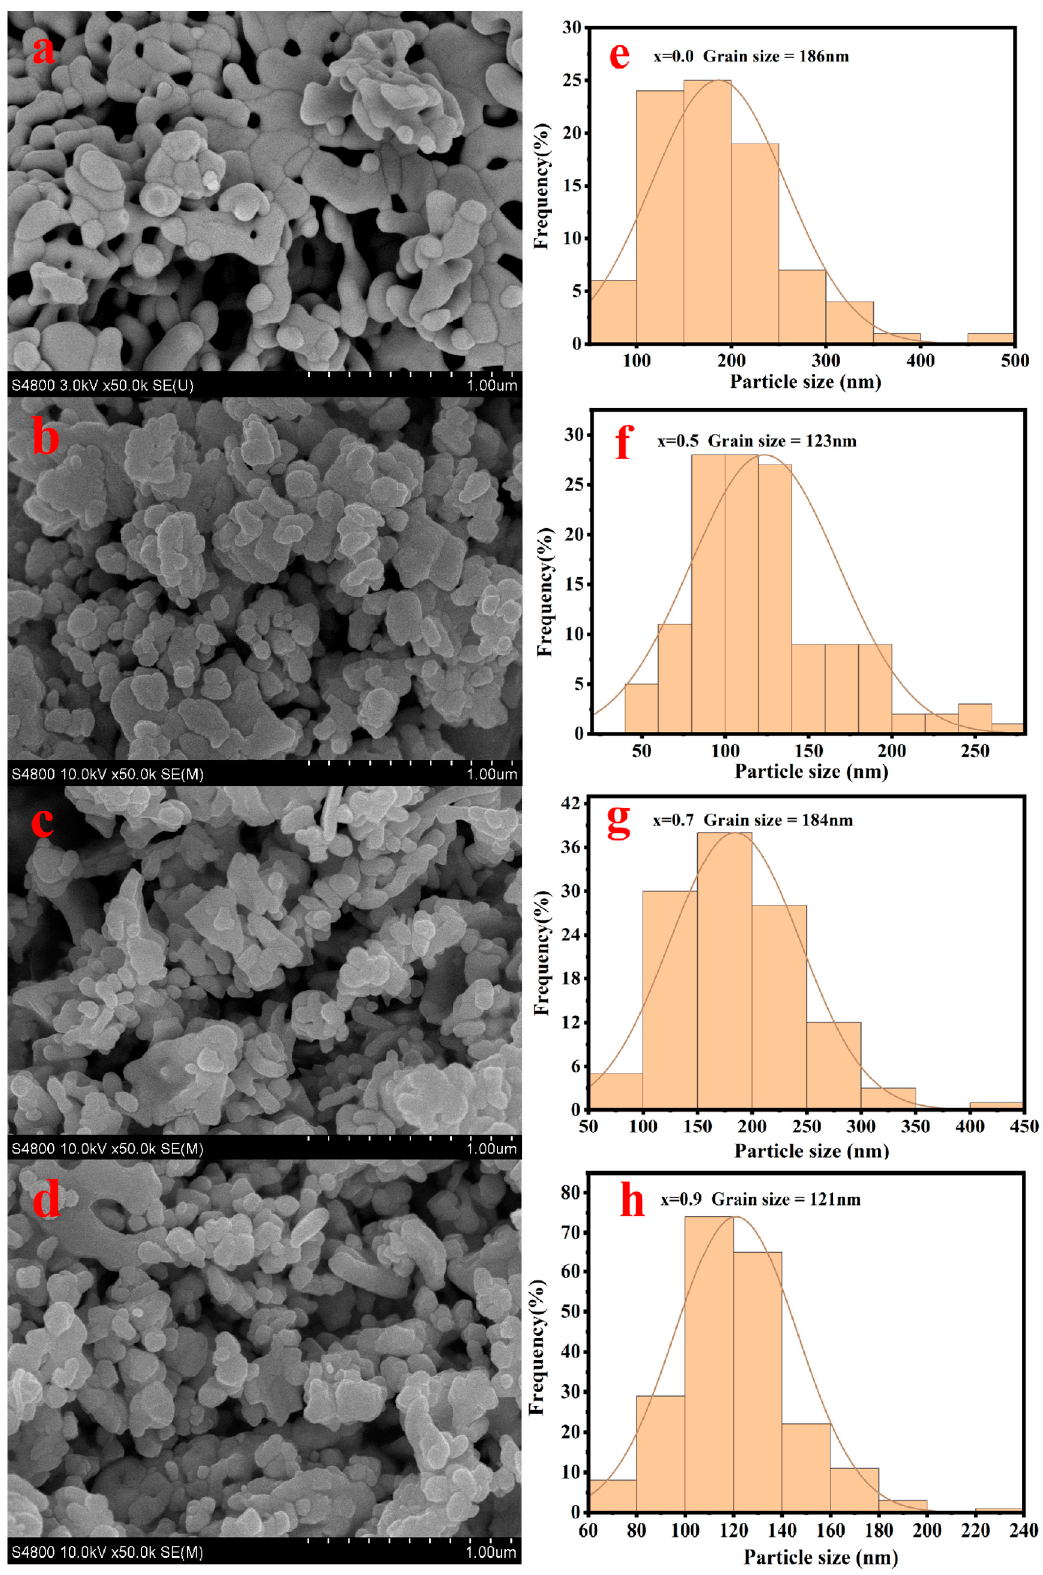
Figure 2. SEM image of ( a ) GFO calcined at 700 ◦ C; ( b ) GBFO5 calcined at 700 ◦ C; ( c ) GBFO7 calcined at 700 ◦ C; ( d ) GBFO9 calcined at 550 ◦ C; ( e – h ) statistical estimation of the particle size distribution of GFO, GBFO5, GBFO7 and GBFO9.